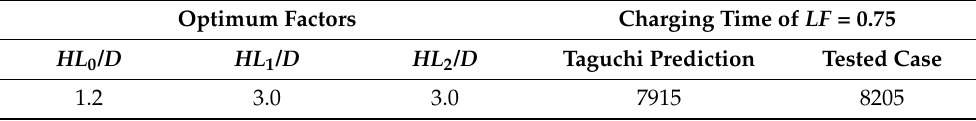
Table 5. The best design for the minimum thermal charging time based on the Taguchi method.